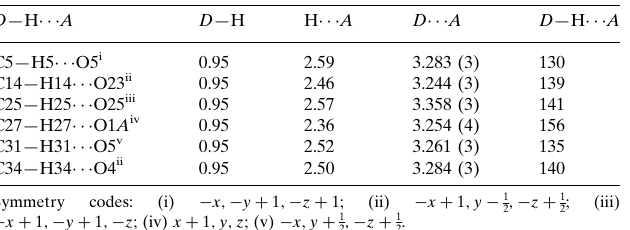
Hydrogen-bond geometry (A˚ , (cid:1)